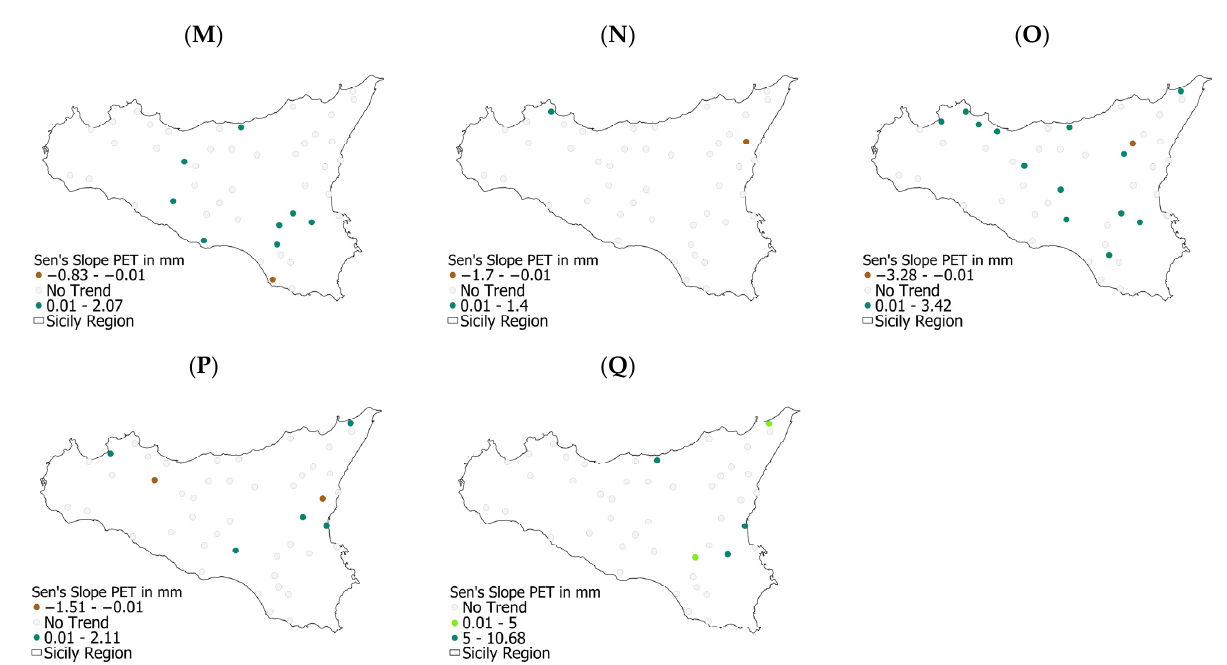
Figure 4. Map of the spatial distribution of the PET trend over Sicily in January ( A ), February ( B ), March ( C ), April ( D ), May ( E ), June ( F ), July ( G ), August ( H ), September ( I ), October ( J ), November ( K ), December ( L ), winter ( M ), spring ( N ), summer ( O ), autumn ( P ), and annually ( Q ).